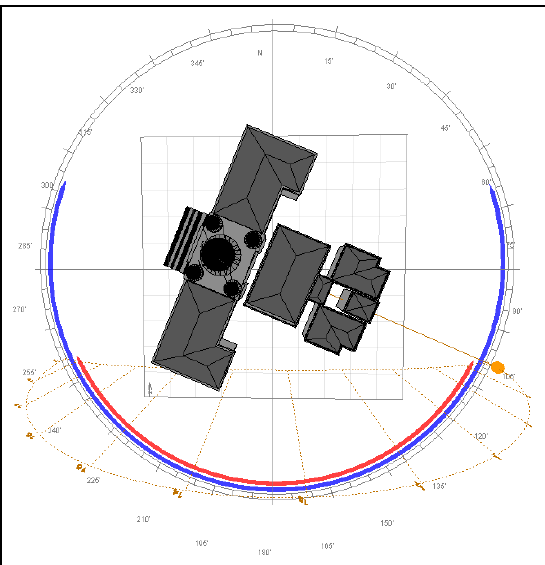
Figure 11. The original position of POJ